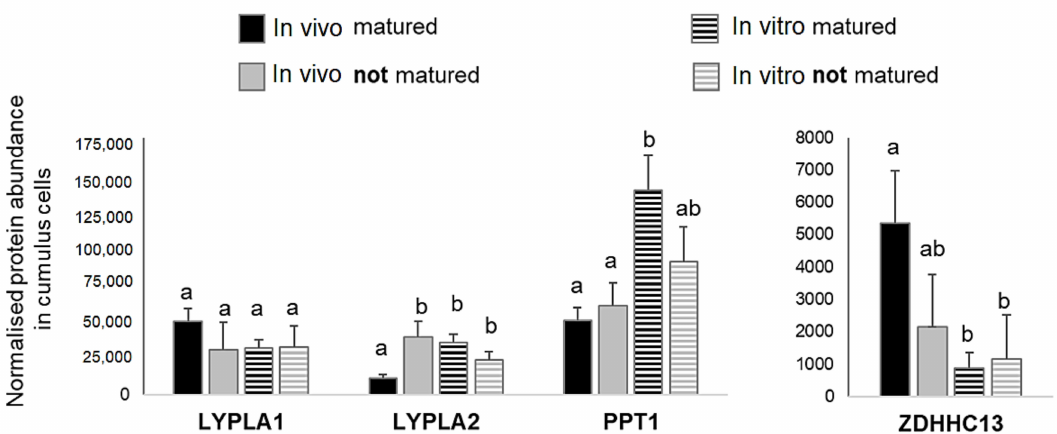
Figure 9. Protein abundance in bovine cumulus cells, surrounding the oocytes either matured or failed to mature after in vivo and in vivo maturation. The values of normalized protein abundance in individual bovine cumulus ( n = 5 per condition) from the recent proteomic study [56] were compared using ANOVA and Tuckey post-hoc test. Different letters signify significant difference at p <